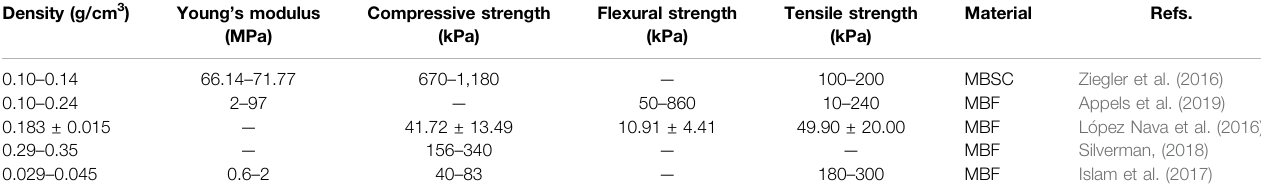
TABLE 2 | The mechanical properties of mycelium-based composites. MBF (cid:2) mycelium-based foam; MBSC (cid:2) mycelium-based sandwich composite. Density (g/cm 3 ) Young ’ s modulus